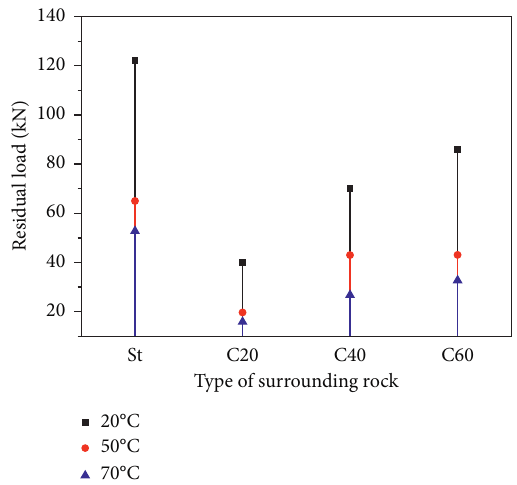
Figure 9: Residual drawing force of